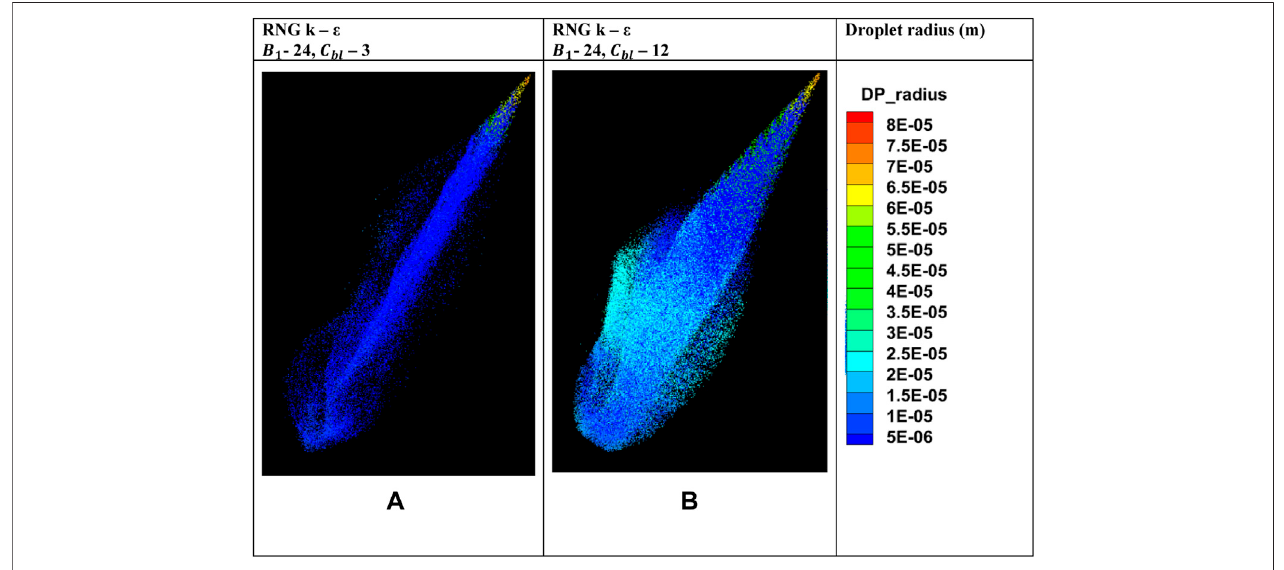
FIGURE7| Comparison ofpredictionsofradiiofsprayparcelsat 0.8 mswithRNGk – ε turbulence modelfortwodifferentvaluesof C bl withsame B 1 [ (A) B 1 =24 and C bl = 3; (B) B 1 = 24 and C bl = 12; cone-angle 25 ° , plume targeting angle 35 ° ].